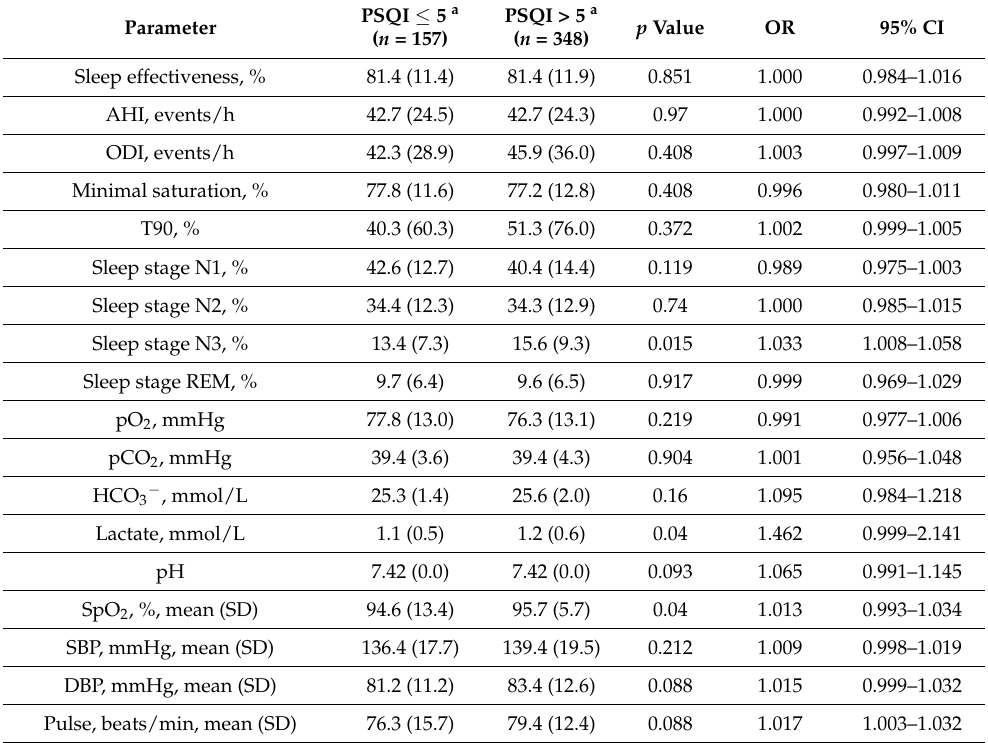
Table 3. Results of polysomnography, arterial blood gas test, and physical examination in the patient groups according to the quality of sleep measured using the PSQI and associations of the parameters with poor sleep